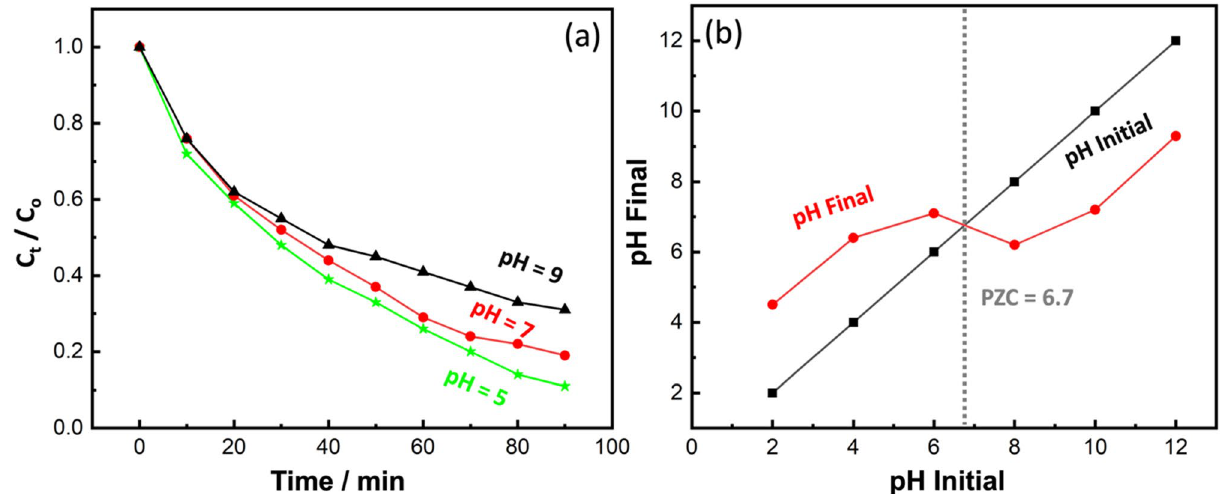
Figure 8. ( a ) Effect of pH value on the degradation percentage of CR by using cocatalyst loaded Al-SrTiO 3 and ( b ) PZC calculation. photocatalyst Degradation efficiency % Time, min Light Source